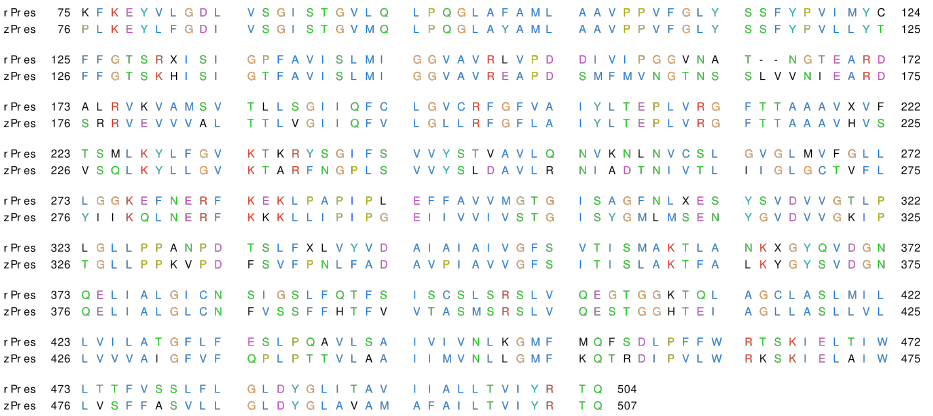
Figure 2. Alignment of rat and zebrafish prestins (rPres and zPres, respectively). The residues are colored according to the ClustalX scheme [54].